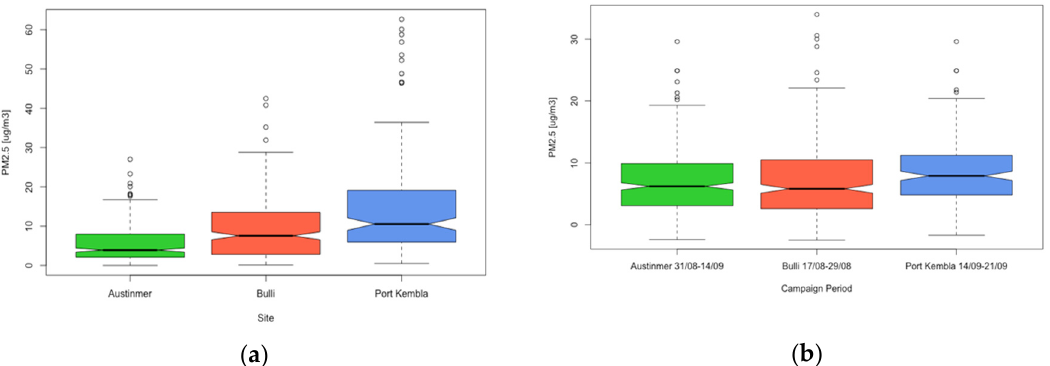
Figure 3. ( a ) Notched boxplots of PM 2.5 ( μ g/m 3 ) hourly concentrations from each of the three